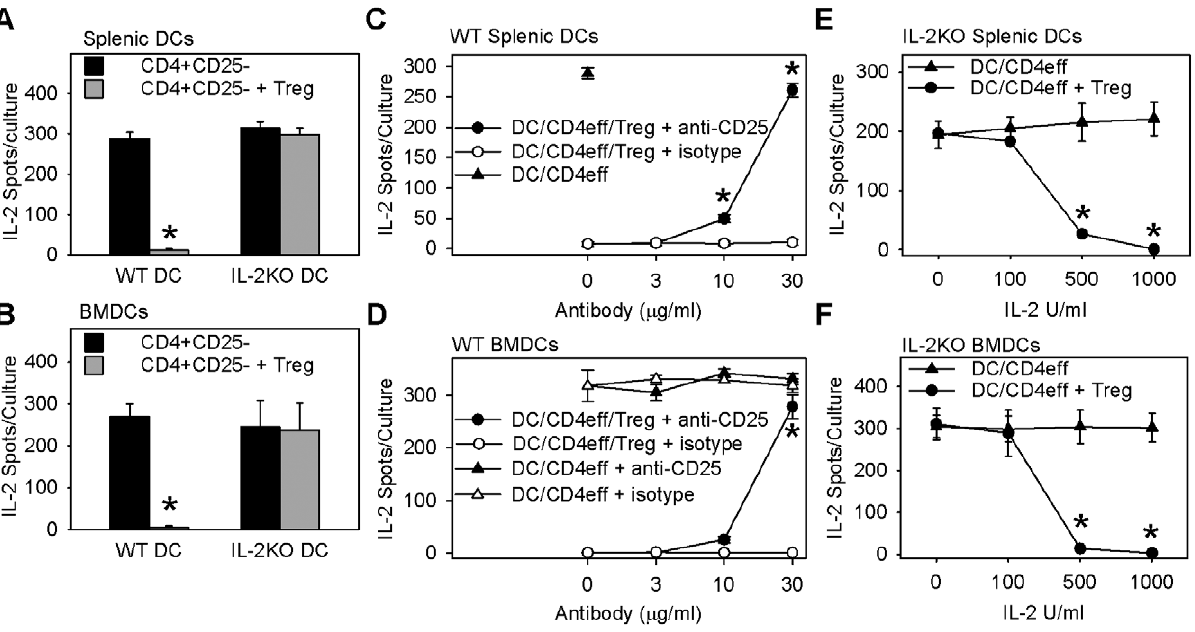
Figure 9. Treg suppression of the MLR-IL-2 response requires dendritic cell IL-2. Panels A–F show Treg suppression of IL-2-secreting cells in primary MLR cultures. MLR cultures of DO11.10 CD4 + CD25 2 cells and allogeneic DCs from WT or IL-2 2 / 2 KO littermates were incubated overnight with or without DO11.10 Tregs, washed, and transferred to IL-2-ELISPOT plates to measure IL-2-secreting cells as per materials and methods. A&B: Tregs fail to suppress MLR-IL-2 response in cultures containing IL-2 2 / 2 KO DCs. Bars are mean 6 SE IL-2 producing cells/culture from N=5 independent experiments with splenic DCs (A) and N=3–4 independent experiments with BMDCs (B). * indicates p , .001 (A) and p , .005 (B) compared with all other conditions, Holm-Sidak method of multiple pairwise comparison. C&D: Anti-CD25 blocks Treg suppression of MLR-IL-2 response. MLR cultures of DO11.10 CD4 + CD25 2 cells and allogeneic WT splenic DCs (C) or BMDCs (D), with or without Treg, were treated with anti- CD25 or isotype control antibody, washed, then transferred to IL-2-ELISPOT plates as in material and methods. C: Symbols are mean 6 SE IL-2 producing cells/culture from N=6 independent experiments. * indicates p , .001, anti-CD25 versus isotype control, Holm-Sidak method of multiple pairwise comparison. D: Symbols are mean 6 SE IL-2-producing cells of triplicate cultures from one of four representative experiments. * indicates p , .001, Treg treatment groups anti-CD25 versus isotype control, Tukey’s test for all pairwise multiple comparison. E&F: Exogenous IL-2 restores Treg suppression of MLR cultures containing IL-2KO DCs. MLR cultures of DO11.10 CD4 + CD25 2 cells and allogeneic IL-2 2 / 2 KO splenic DCs (E) or BMDCs (F), with or without Treg, were treated with exogenous IL-2, washed, then transferred to IL-2 ELISPOT plates as in material and methods. Symbols are mean 6 SE IL-2 producing cells of triplicate cultures from one of three representative experiments. * indicates p , .001, IL-2 treatment DC/CD4eff + Treg versus DC/CD4eff control, Tukey’s test for all pairwise multiple comparison.